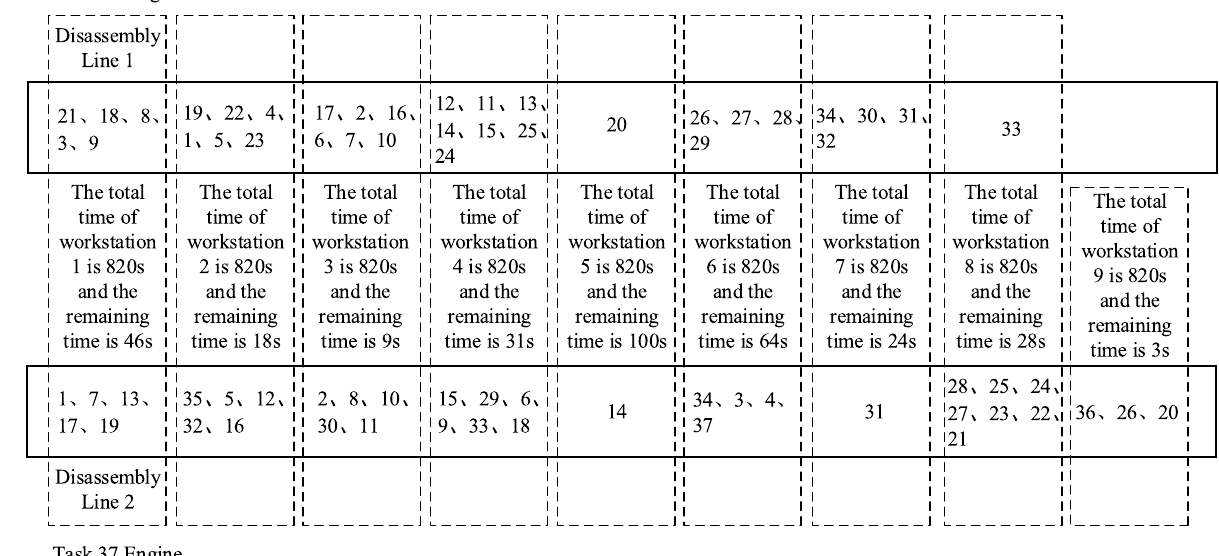
Figure 6. Parallel mixed-flow disassembly line layout for plan 1.